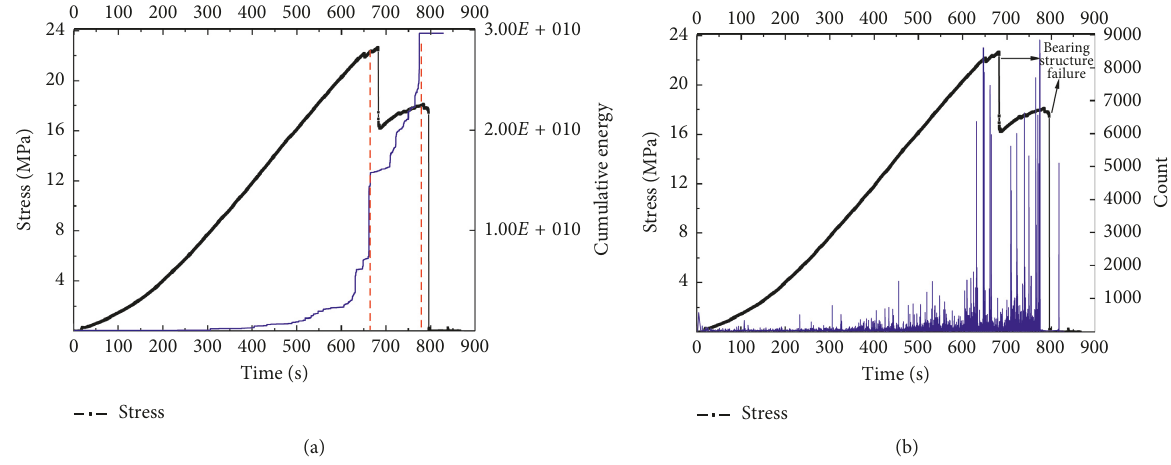
Figure 11: Acoustic emission characteristics of 5 # sample: (a) cumulative energy; (b)